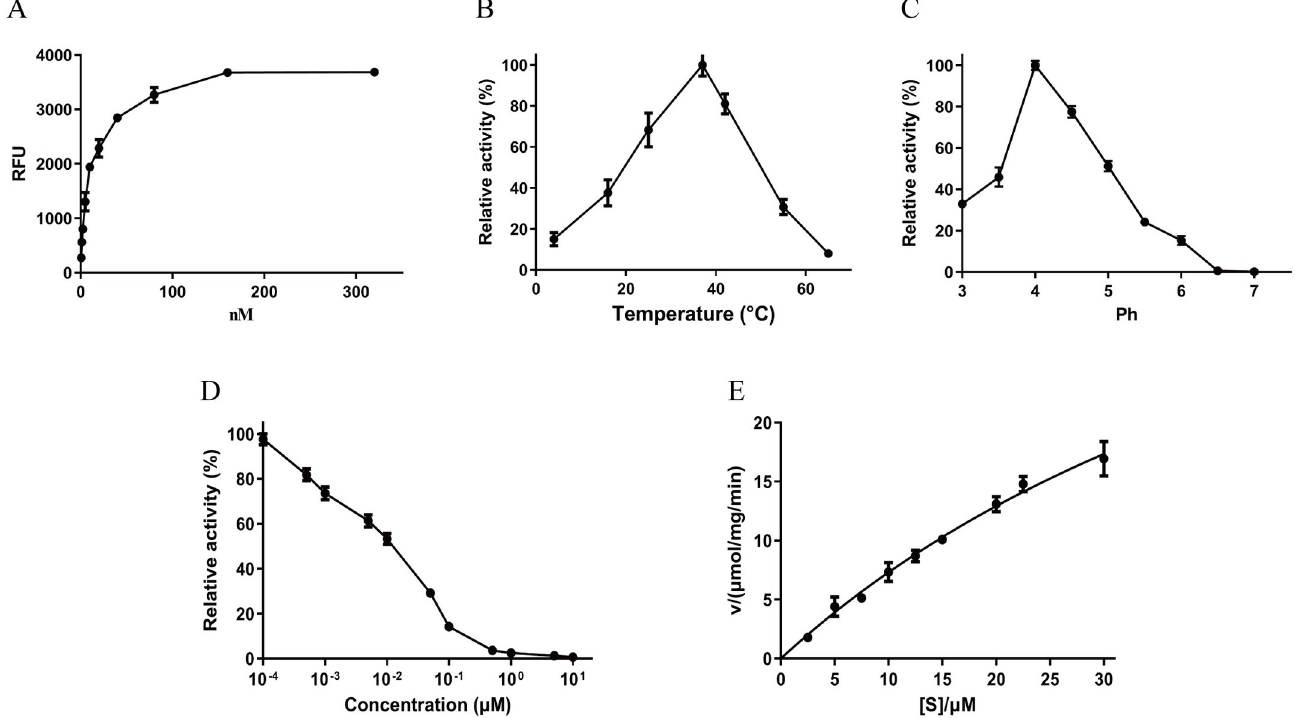
Fig 5. Biochemical properties of ySjCB2. (A) Enzyme activity of ySjCB2 was determined by fluorescent substrate Z-FR-MCA under different enzyme concentrations (0.625, 1.25, 2.5, 5.0, 10.0, 20.0, 40.0, 80.0, 160.0 and 320.0 nM). (B) Optimal temperature at pH 4.0. Maximal activity was shown as 100%. (C) Optimal pH, enzyme activity was assayed in various pH buffers ranging from pH 3.0–8.0. Maximal activity was shown as 100%. (D) Inhibition profile for E-64 was determined by incubating ySjCB2 (50 nM) with different concentrations of E-64 in 100 mM acetic acid-sodium acetate (pH 4.0) buffer at room temperature for 30 min. Residual activities (%) were determined using Z-FR-MCA as a substrate. (E) The Michaelis–Menten curve, at 37˚C, pH 4.0.